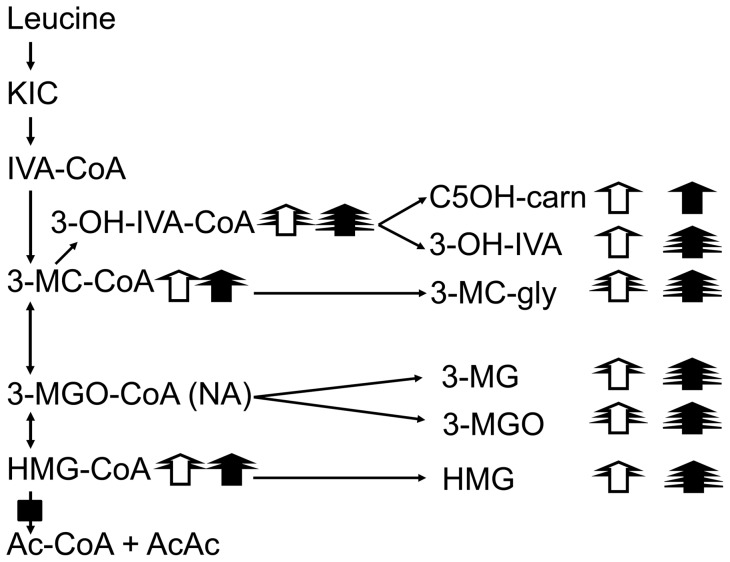
Patterns of leucine-related liver acyl-CoAs and urine and plasma metabolites.The intermediates of leucine degradation are shown on the left. The metabolic block at HL is shown. Related urine and plasma metabolites are shown on the right. The number of arrowheads reflects the magnitude of increase with respect to normal, nonstressed control mice for HLLKO mice under normal conditions (unfilled arrows) and during decompensations filled arrows: 1 arrowhead, 3 to <9-fold increase; 2, 9-<27X; 3, 27-<81X; 4, >81X. Abbreviations, IVA-CoA, isovaleryl-CoA; 3-MC-CoA: 3-methylcrotonyl-CoA; 3-MGO-CoA, 3-methylglutaconyl-CoA; 3-OH-IVA-CoA, 3-hydroxyisovaleryl-CoA; C5OH-carn: C5 hydroxycarnitine; 3-OH-IVA, 3-hydroxyisovaleric acid; 3-MC-gly, 3-methylcrotonylglycine; 3-MGO, 3-methylglutaconic acid; 3-MG, 3-methylglutaric acid. NA, not available (see text).